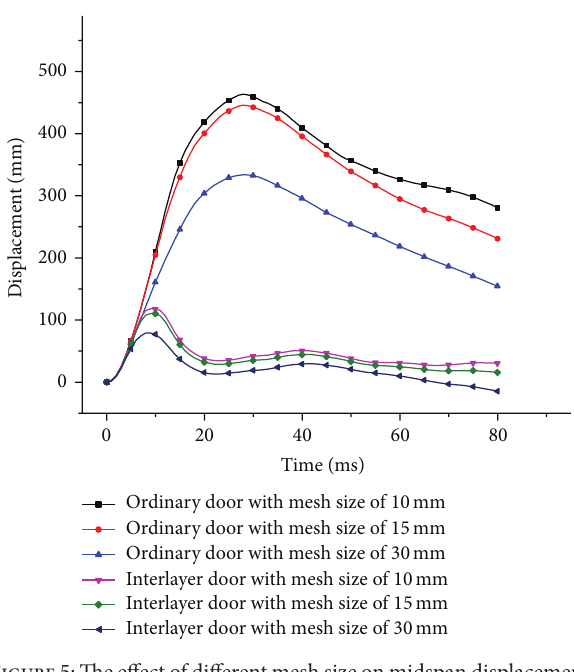
Figure 5: The effect of different mesh size on midspan displacement of blast door.